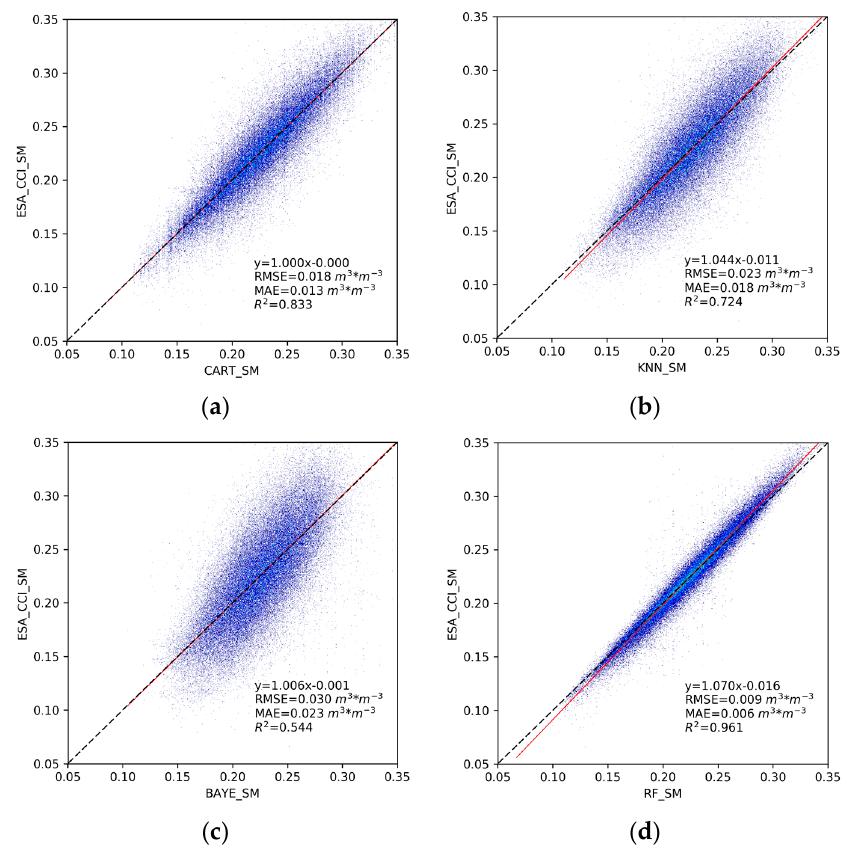
Figure 4. Scatterplots, linear regression equations, RMSEs, MAEs and R 2 between ESA CCI SM and: